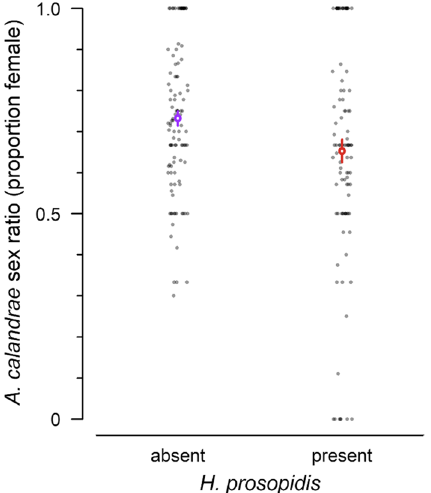
Figure 2. Offspring sex ratio of the native parasitoid Anisopteromalus calandrae in the absence and presence of the nonnative parasitoid Heterospilus prosopidis ( p = 0.028). Open circles with error bars overlayed on the data indicate the mean ± SE.